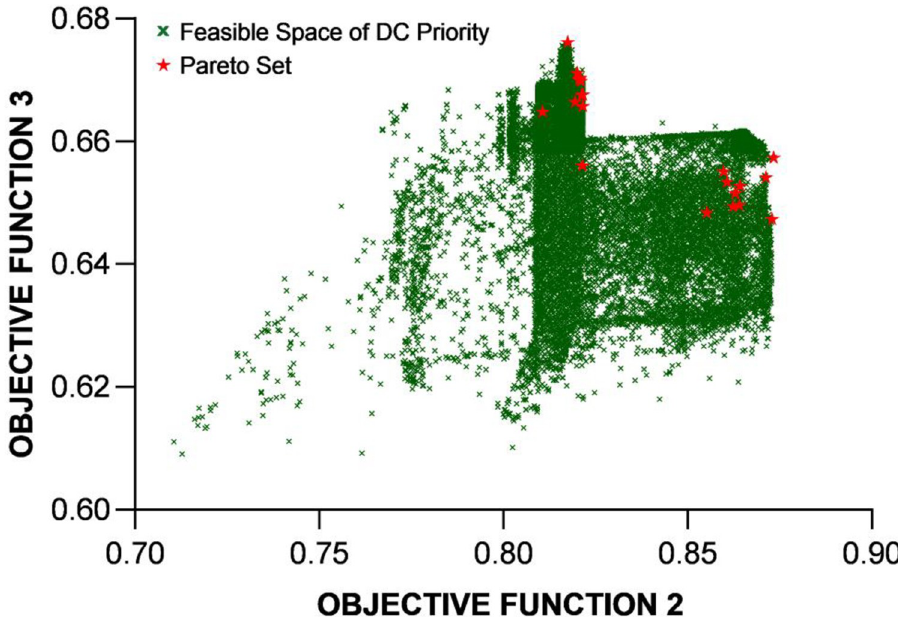
Fig 13. The profile of feasible solutions under the 21 scenarios and the Pareto set for the two objective functions under the DC priority operation mode.